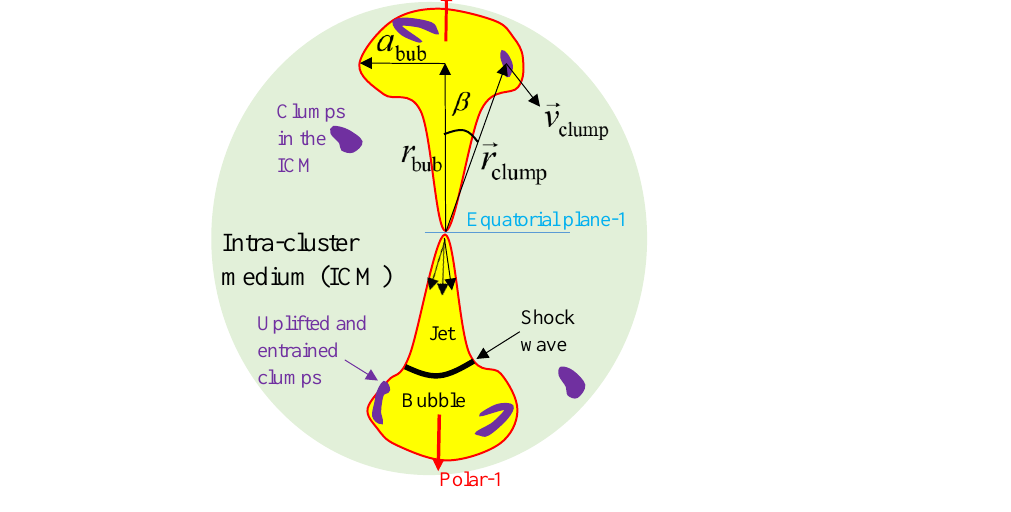
Figure 1. A schematic drawing in a meridional plane of the flow structure where jet-inflated bubbles and jets (yellow) entrain and uplift dense cold gas (in purple). The jets and the bubbles they inflate accelerate clumps mainly in meridional planes. As such, each clump acquires angular momentum at a large angle compared to the original jets’ axis (polar-1). When the SMBH accretes these clumps, their angular momentum sums up to form an accretion disk with an angular momentum axis (polar-2) at a large angle compared to polar-1. Therefore, the jets of the next outburst (jet launching episode) will have their axis (polar-2) at a large angle compared to